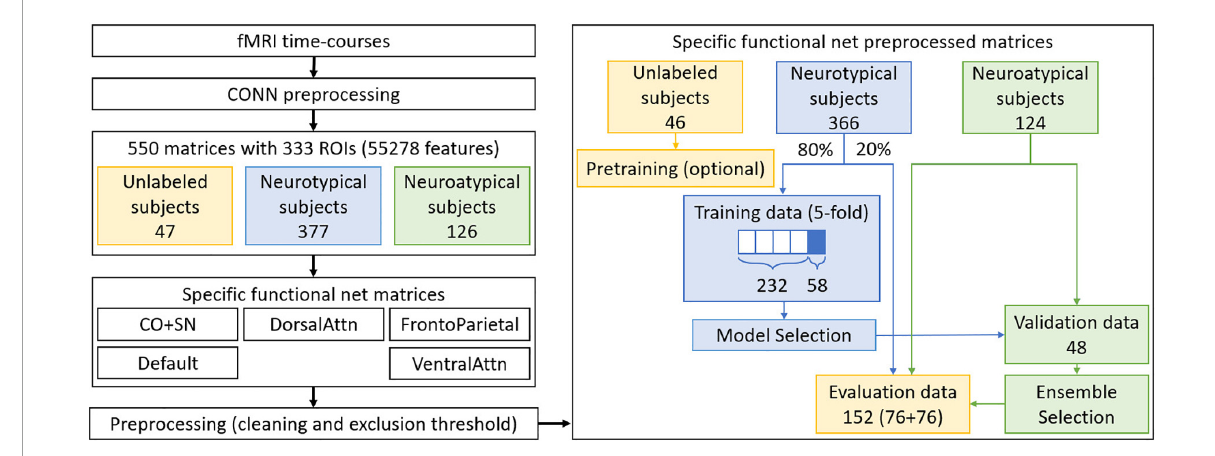
FIGURE1 Preprocessing steps performed for datasets preparation. In blue, neurotypical data and processes only involving this type of data are identified. In green, the same is done for neuroatypical data, while parts of the process involving a mixture of these two types of data are identified in yellow. Note that only neurotypical subjects’ data is used for GAN training while a balanced evaluation dataset is used for the evaluation